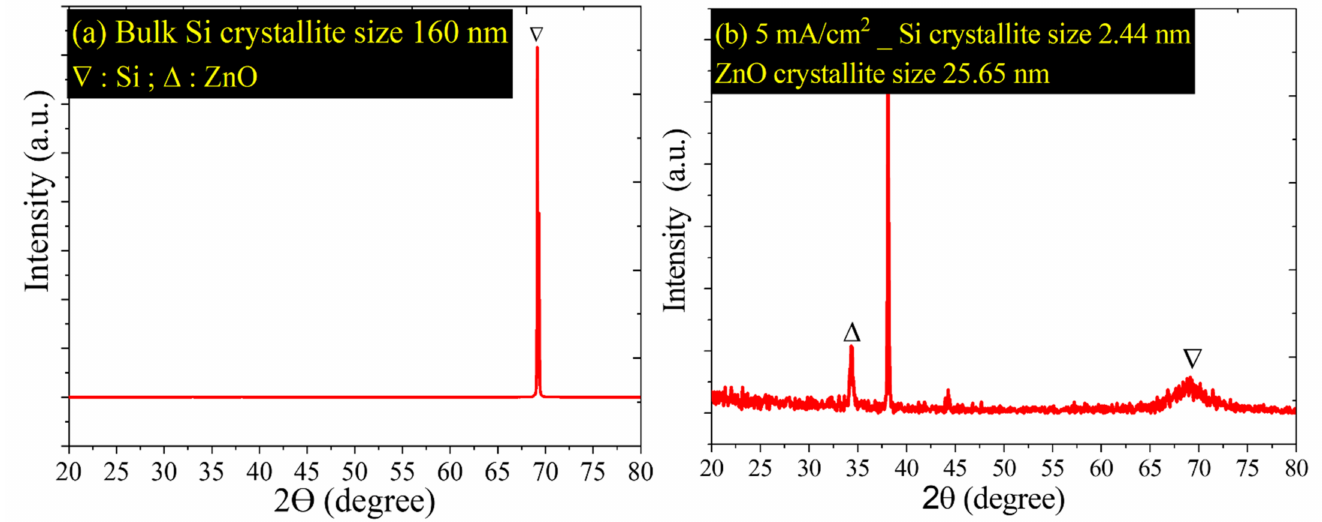
Figure 3. XRD analysis for ( a ) bulk Si; ( b ) ZnPSi at etching current density of 5 mA/cm 2